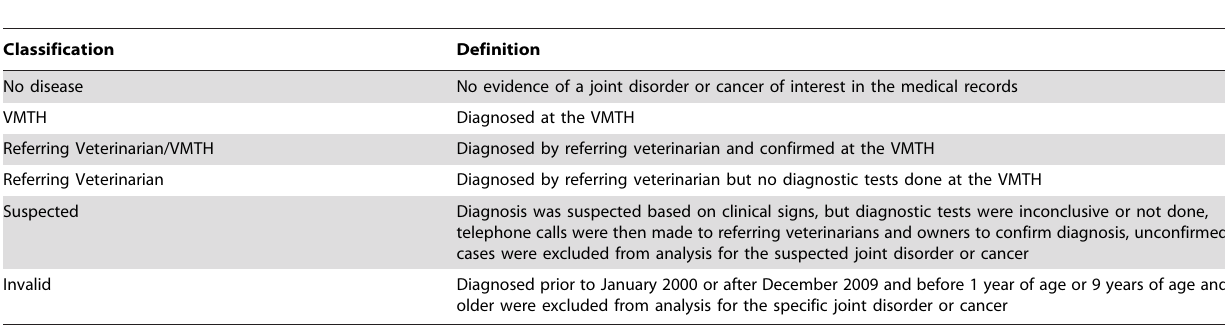
Table 1. Categories used in determining diagnosis for joint disorders and cancers of interest in Golden Retrievers (1–8 years old) admitted to the Veterinary Medical Hospital, University of California, Davis, from